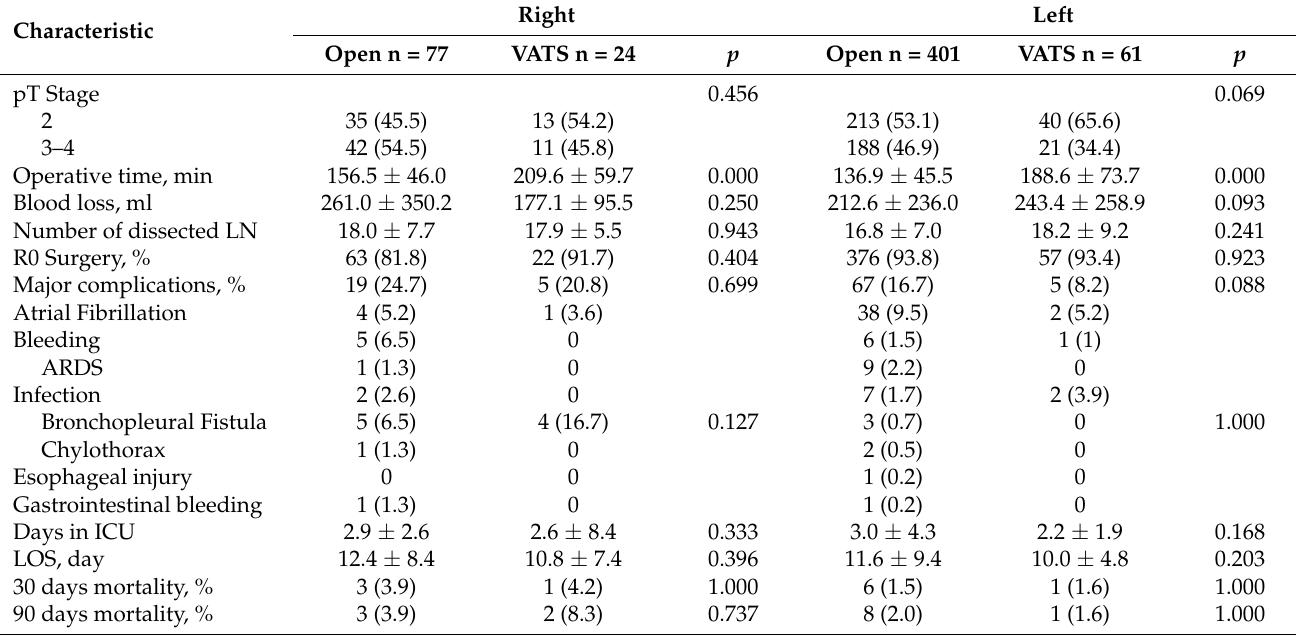
Table 5. Clinical characteristics and perioperative outcomes between Open and VATS pneumonec- tomy on the right and the left